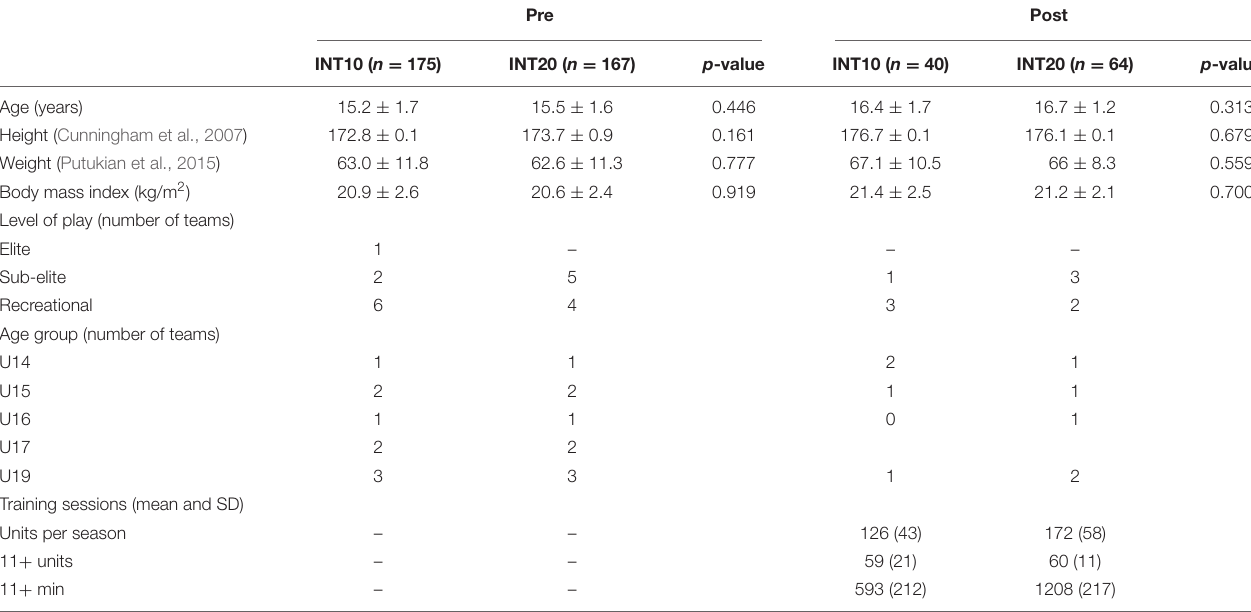
TABLE 1 | Baseline demographics and team characteristics of the sample separated in pre and post-test (only analyzed sample).